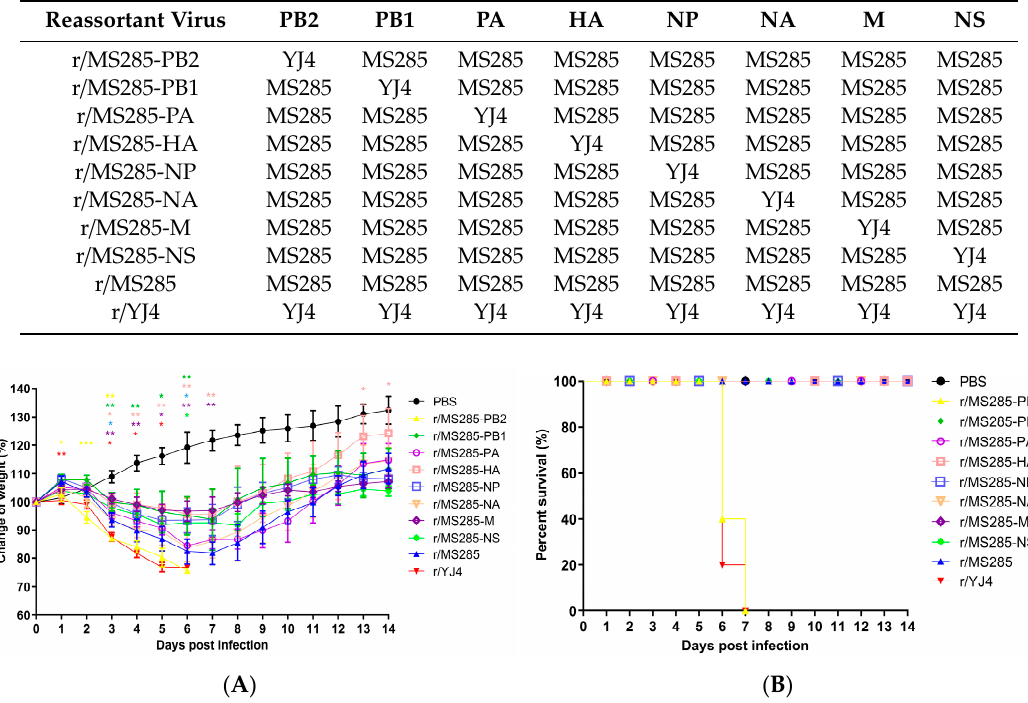
Figure 2. Weight changes and survival rates of mice infected with MS285 reassortant viruses. Six-week-old female BALB/c mice were inoculated intranasally with a series of reassortant viruses at 10 6 TCID 50 . The body weight change rate ( A ) and survival rate ( B ) in the infected mice were continuously recorded for 14 days. Mice with weight loss of more than 25% of their initial body weight were euthanized humanely. Significant body weight changes of the single fragment recombinant virus-inoculated mice compared with r/MS285 virus-inoculated mice (* p < 0.05; ** p < 0.01; *** p < 0.001).